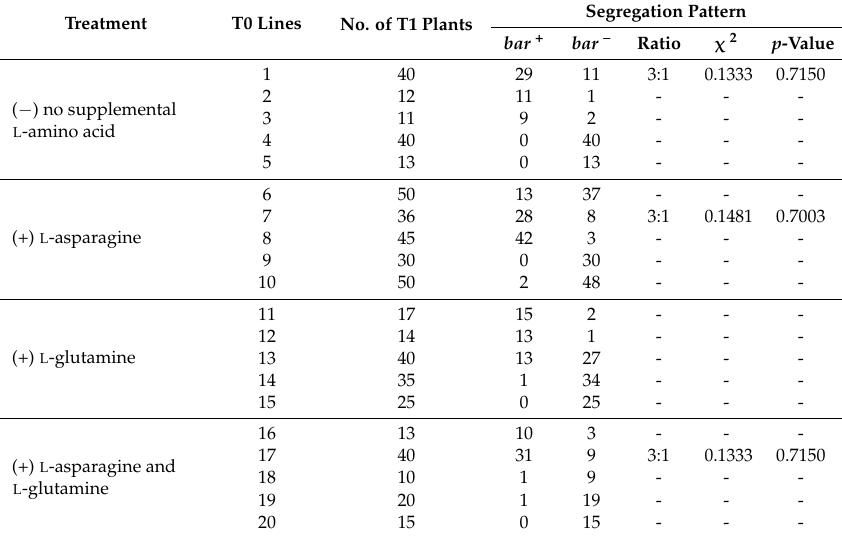
Table 6. Segregation of bar gene in the T1 plants for the different treatments. Treatment